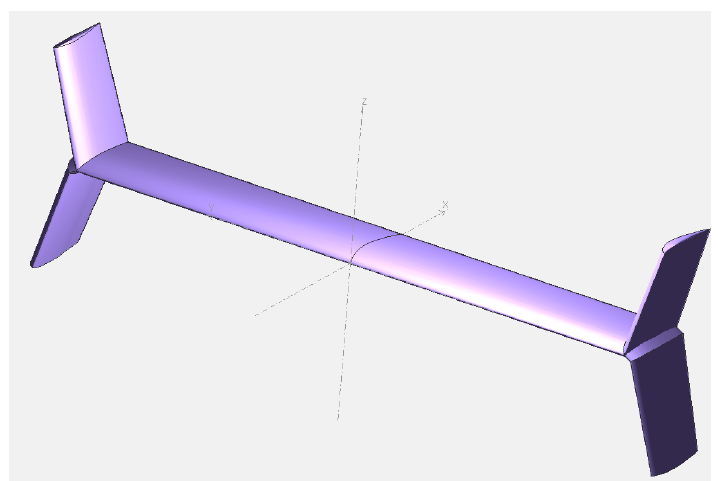
Figure 3. Main wing configuration of Vahana by using XFLR5.